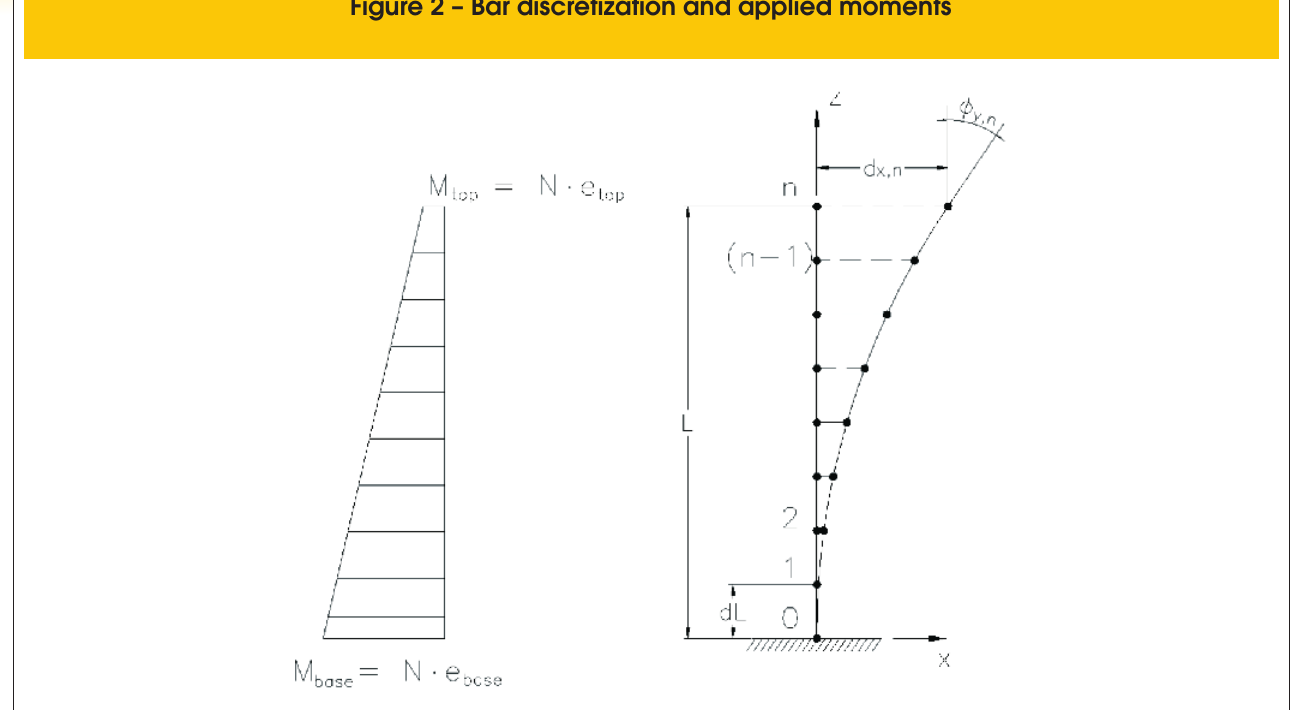
Figure 2 – Bar discretization and applied moments